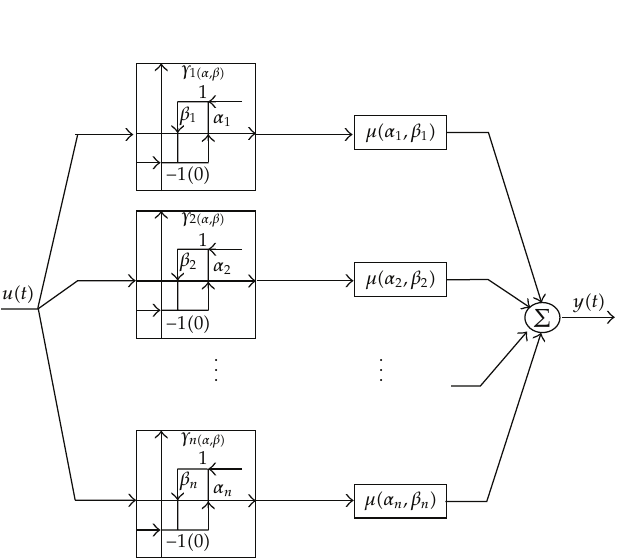
Figure 2: Block representation of the classical Preisach